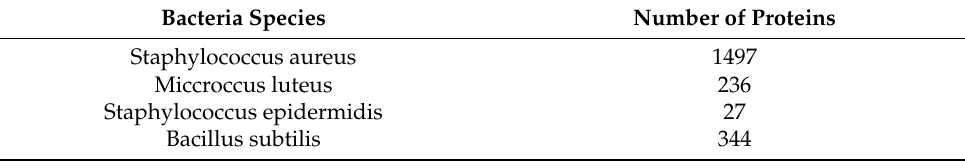
Table 2. Number of collected proteins sequences of each species.